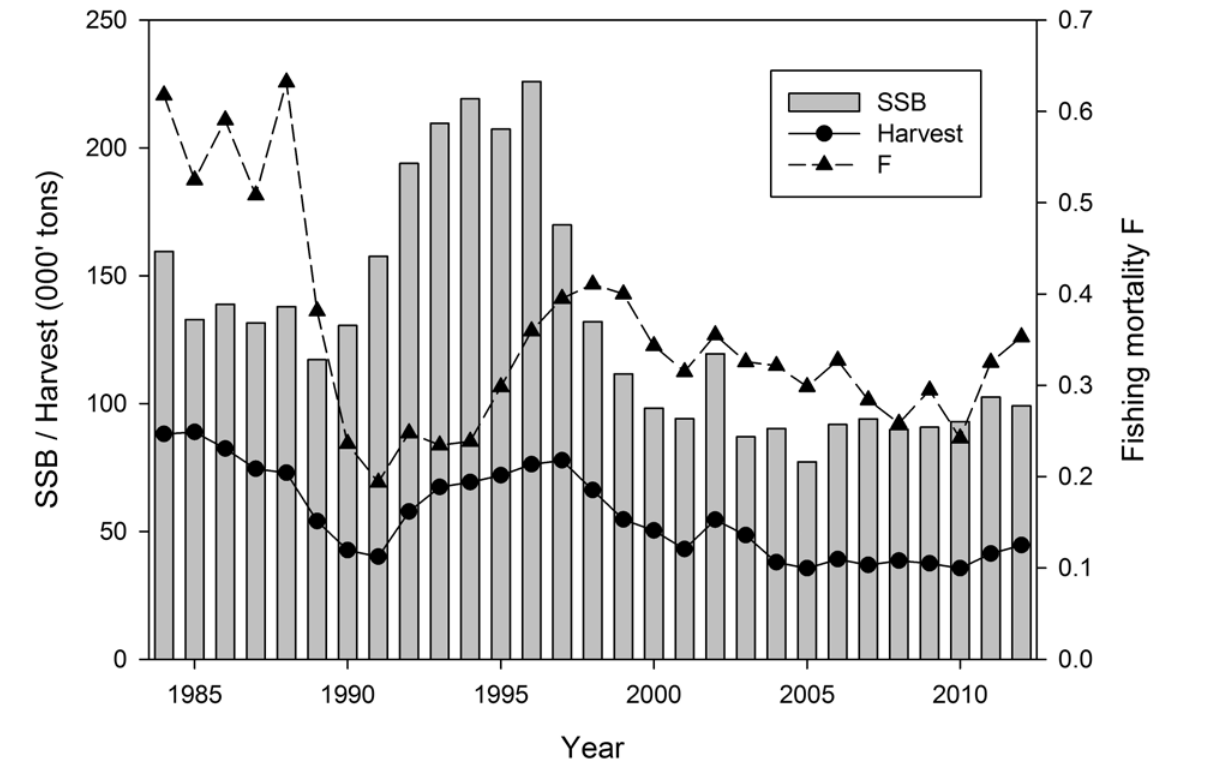
Fig 1. Stock dynamics. Spawning Stock Biomass (SSB), harvest and fishing mortality of Norwegian coastal cod.